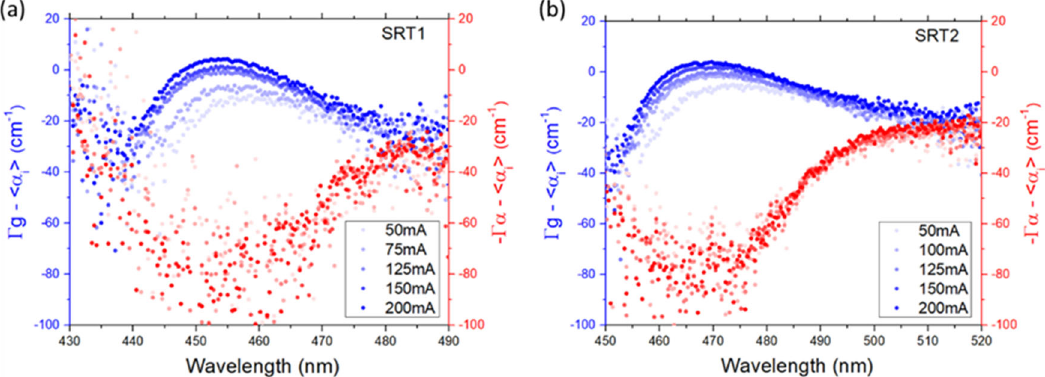
Figure 4. Gain and loss spectra of ( a ) SRT1 and ( b ) SRT2 from segmented contact measurement. The measured absorption coefficient (cid:104) α DL (cid:105) from transmission measurement was 6 × 10 4 –8 × 10 4 cm − 1 in a wavelength range of 455–470 nm although not shown here. By multiplying the simulated confinement factor in DL ( Γ DL ) and (cid:104) α DL (cid:105) , absorption loss of DL ( α DL )